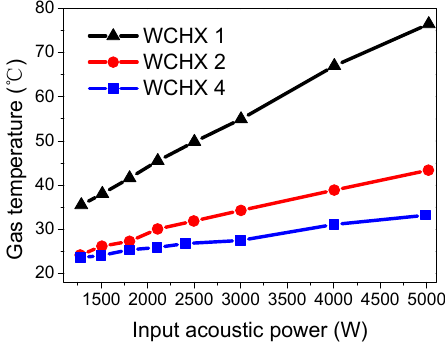
Figure 5. Gas temperatures at the inlets of WCHXs 1, 2, and 4.